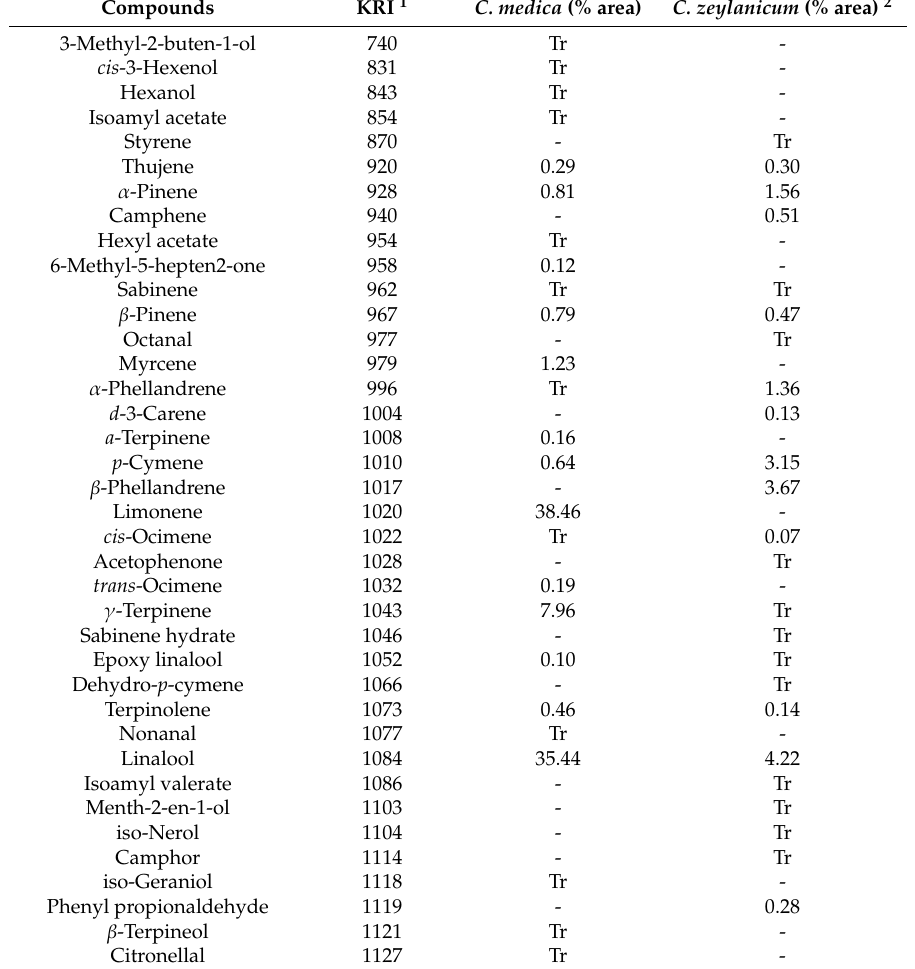
Table 1. Relative percentage (%) area of volatiles identified in Citrus medica and Cinnamomum zeylanicum essential oils (Eos) by GC / MS